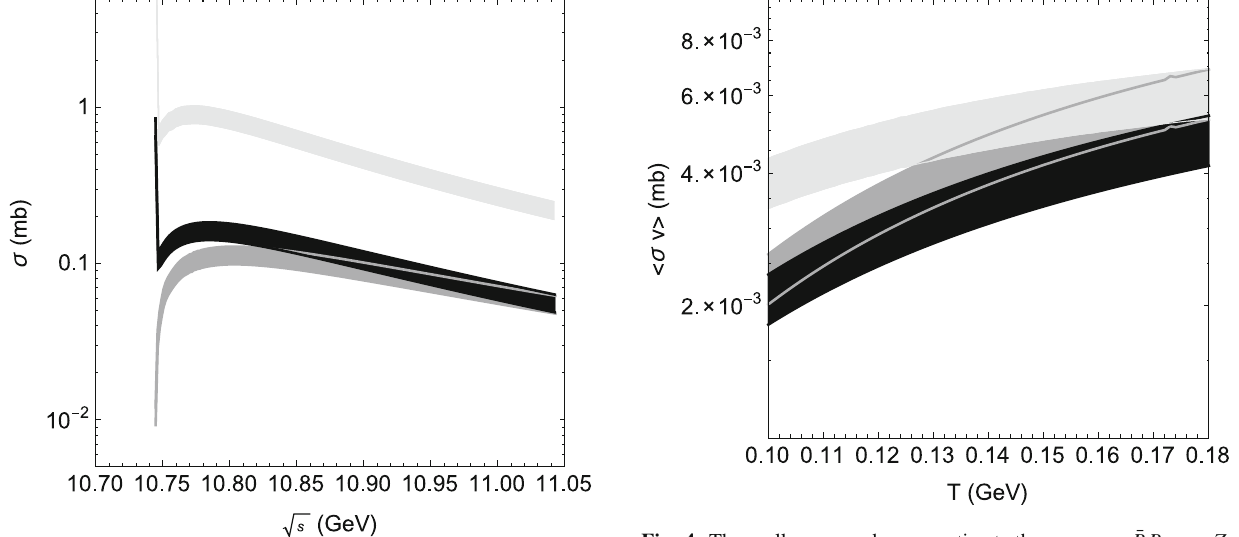
Fig. 4 Thermally averaged cross section to the processes ¯ BB → π Z b (medium shaded region), ¯ B ∗ B → π Z b (dark shaded region) and ¯ B ∗ B ∗ → π Z b (light shaded region), as a function of temperature √ s